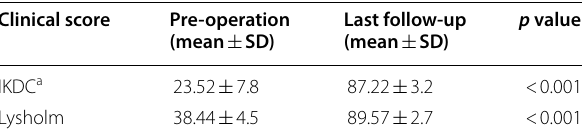
Table 1 IKDC and Lysholm scores of the patients before